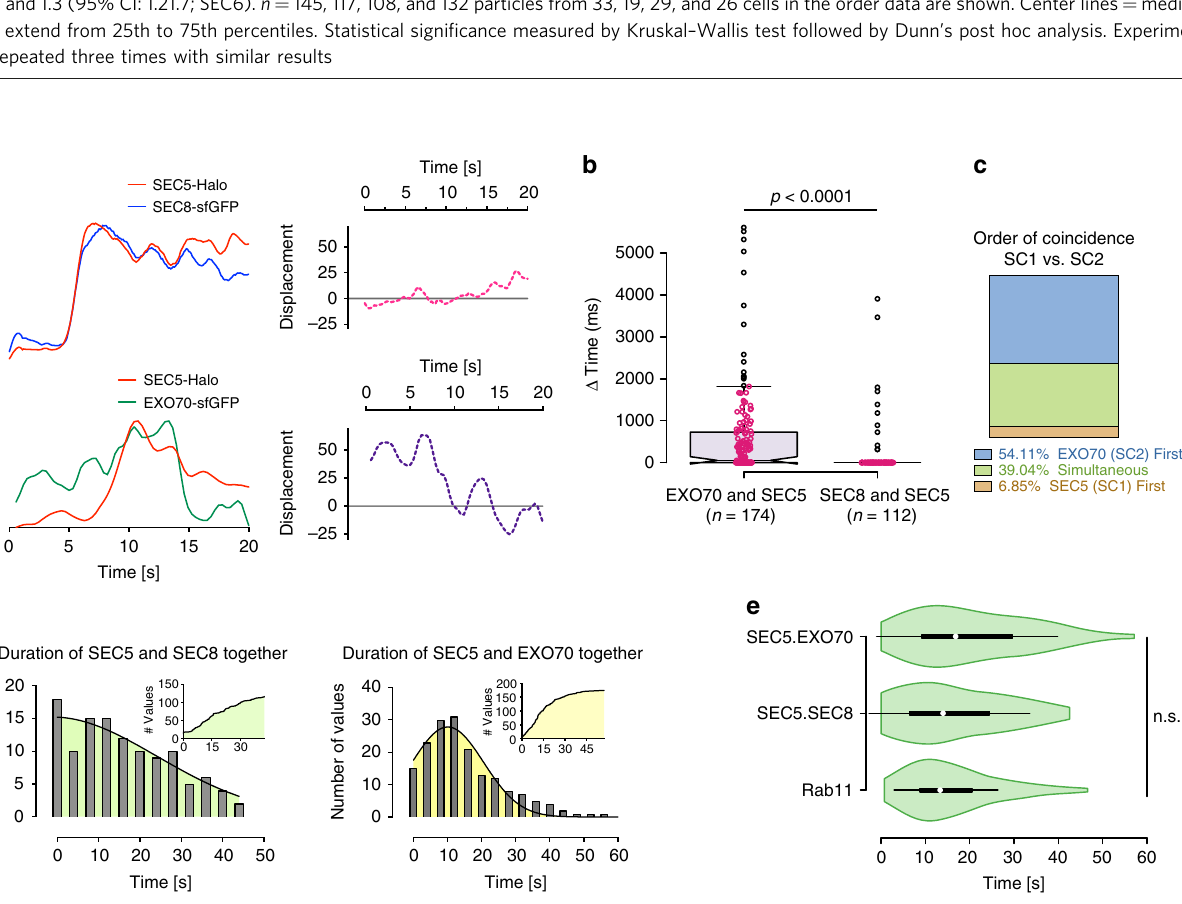
Fig. 3 Sec3 departs from the exocyst complex prior to vesicle fusion. a Schematic representation of the data. b NMuMG cells were transduced with mApple-Rab11 and VAMP2-pHluorin lentivirus and imaged by TIRFM. Kymographs show arrival and departure of mApple-Rab11 and vesicle fusion, highlighted by VAMP2-pHluorin fl ashes. Speed = 5 Hz. Scale bar = 5 s. c Distribution of mApple-Rab11 arrival times prior to vesicle fusions. The inset shows box and whisker plot; center line = − 14.6 s (median; 95% CI: − 16.6 to − 12.5). Error bars = Tukey ’ s range. d Intensity trace over time for VAMP2- pHluorin and TfR-pHuji. The peak intensities denote fl ashes resulting from vesicle fusion. Speed = 5 Hz. e Effects of exocyst subunits depletion on vesicle fusion activities in NMuMG cells assessed using VAMP2-pHluorin. n = 32, 32, 18, 22, 21, 22. P- values compared to control. f Kymographs showing an itinerary of SEC3-GFP, SEC5-GFP, SEC6-GFP, and EXO70-GFP arrivals/departures with respect to the vesicle fusion marker TfR-pHuji. Square images show snapshots in the green and red channels at the time of vesicle fusions. Scale bar = 5 s. g, h Quanti fi cation of exocyst subunit arrival and departure times at and from the vesicle fusion site shown in E. Data points shown as dots. g Median arrival times in seconds: − 11.7 (95% CI: − 12.9 to − 9.1; EXO70), − 11.6 (95% CI: − 14.6 to − 10.2; SEC3), − 10.6 (95% CI: − 14.0 to − 8.2; SEC5), and − 10.3 (95% CI: − 12.3 to − 8.8; SEC6). n = 146, 132, 108, and 132 objects in the order data shown. h Median departure times in seconds: 1.4 (95% CI: 1.2 – 1.5; EXO70), − 0.4 (95% CI: − 0.98 to − 0.69; SEC3), 1.3 (95% CI: 1.21.6;